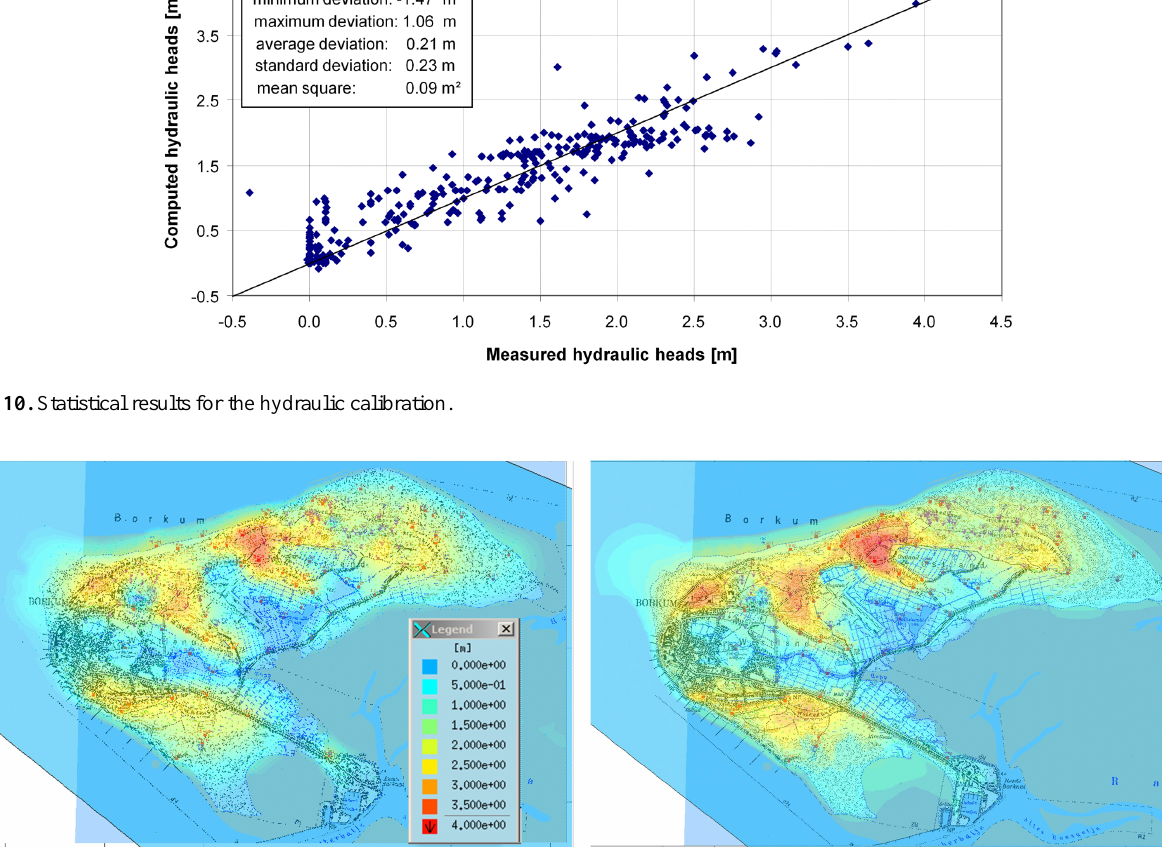
interpolation between measured hydraulic head values, using for instance a Kriging